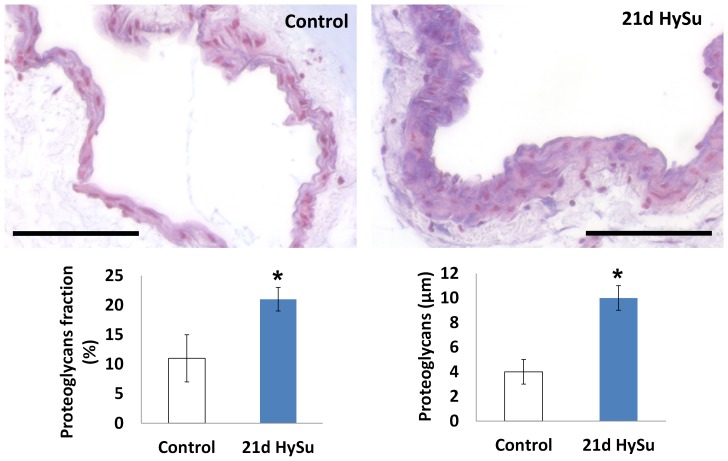
Alcian blue staining for proteoglycans (blue) in control and 21d HySu PAs.Scale bar  =  100 µm. Both area fraction (%) and the total thickness of proteoglycans were increased in 21d HySu PAs. N  =  6 per group. Means ± Standard Errors. * p<0.05 vs. control.